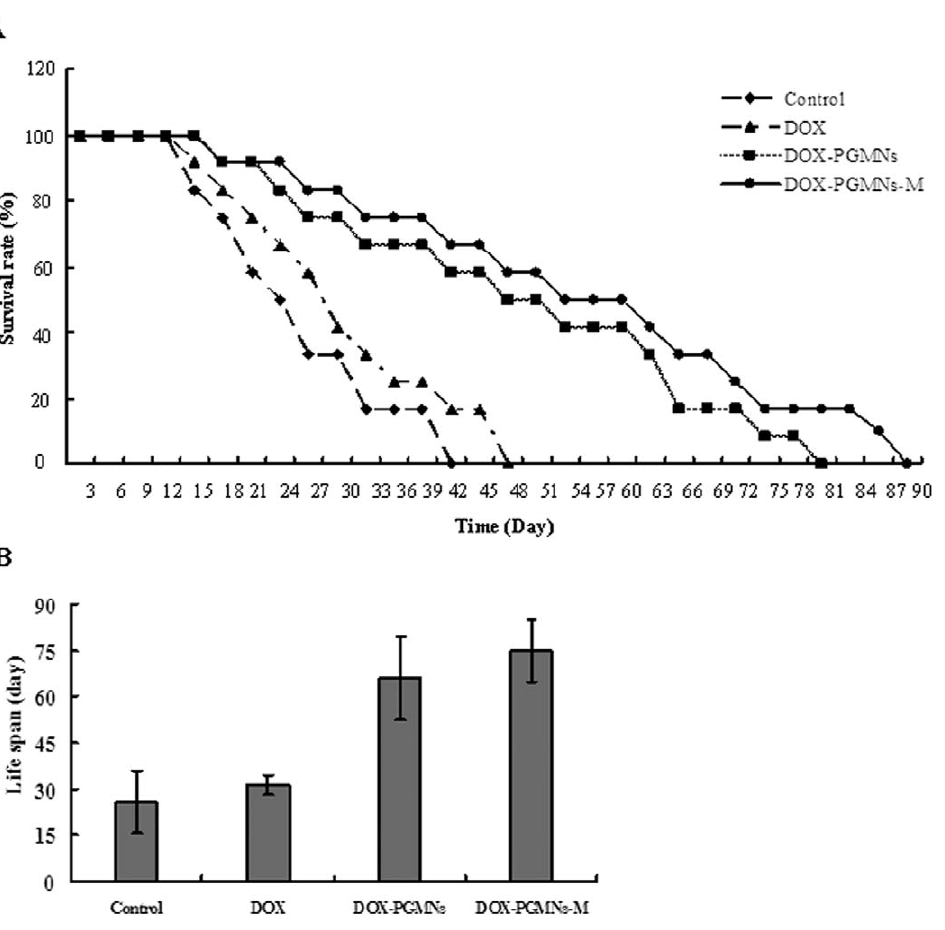
Figure 6. The survival as a function of time and life span of H22 tumor-bearing mice model that received different treatments. (A) The survival as a function of time of the tumor-bearing mice of the DOX-PGMNPs-M group. (B)There is a significantly increased life span of the tumor- bearing mice of the DOX-PGMNPs-M group.